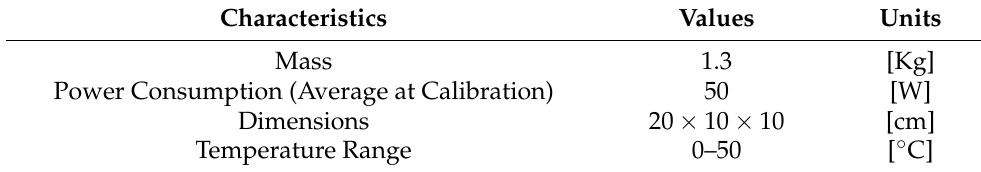
Table 2 summarises the final main payload physical characteristics. Table 2. Final payload